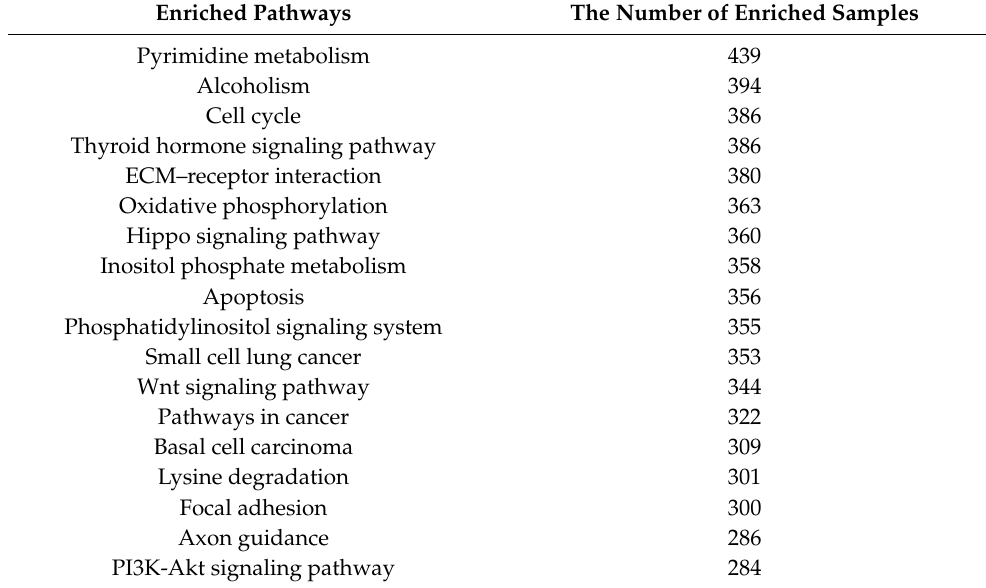
Table 1. Enriched pathways that were enriched in more than 50% of the